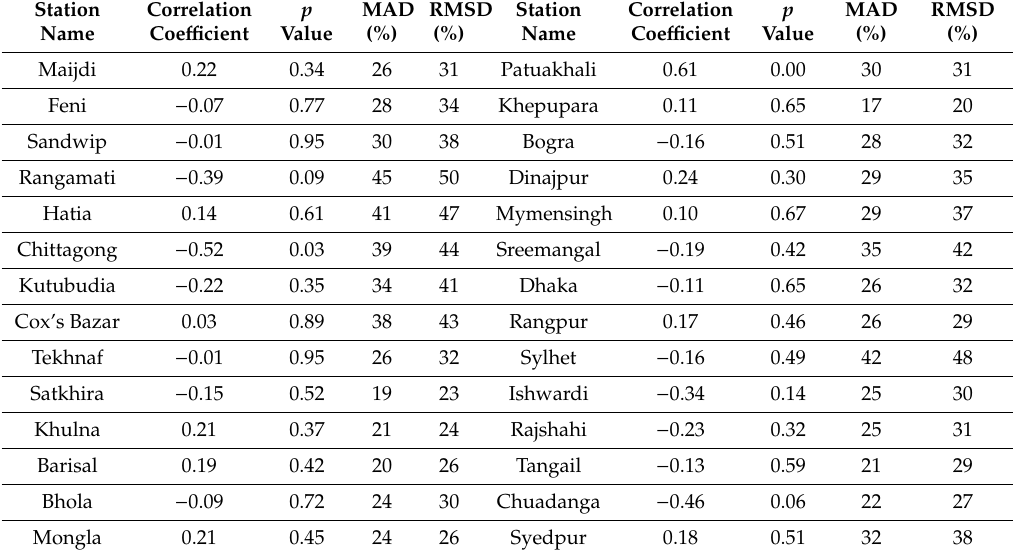
Table 1. Performance of the PRECIS Model in Simulation of Annual Rainfall of Bangladesh.